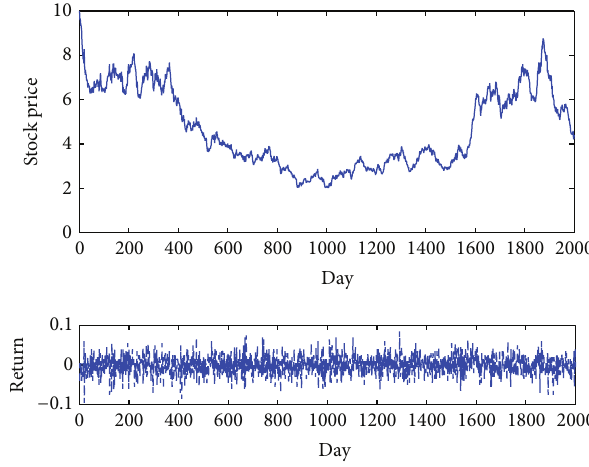
Figure 1: Fluctuations of prices and returns, respectively, for the financial price